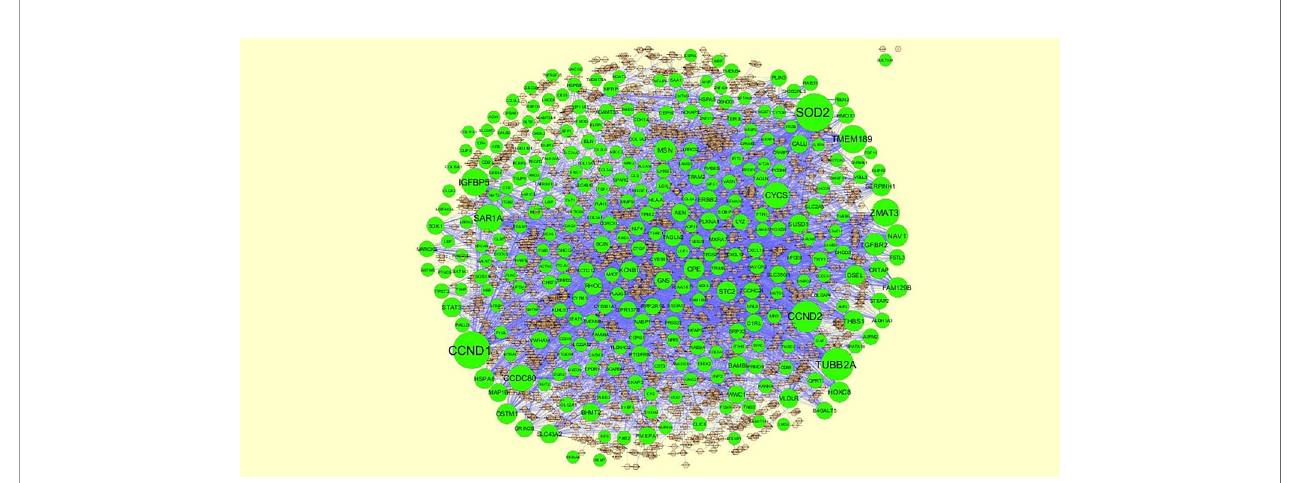
FIGURE 7 | The network of up regulated genes and their related miRNAs. The green circles nodes are the up regulated genes, and chocolate diamond nodes are the